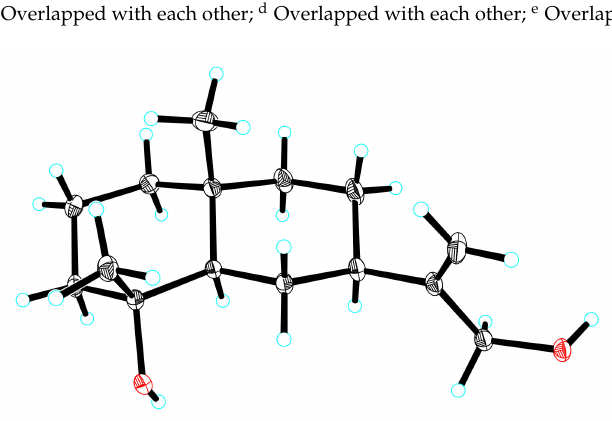
Figure 8. Single crystal X-ray structure of Compound 10 .